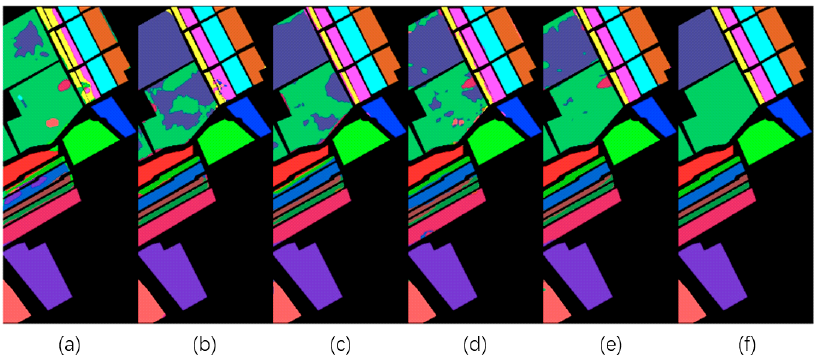
Table 4. Accuracy comparison of different methods for 0.5% samples of Pavia University.